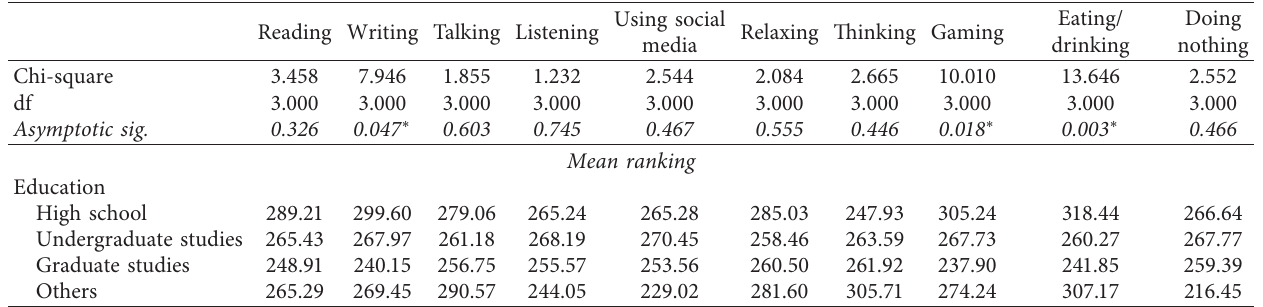
Table 17: Kruskal–Wallis test statistics and the rankings of educational groups.